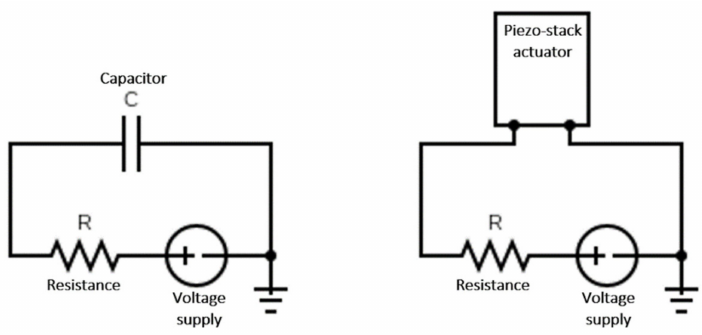
Figure 6. Analogy between RC circuit and circuit with piezo-stack